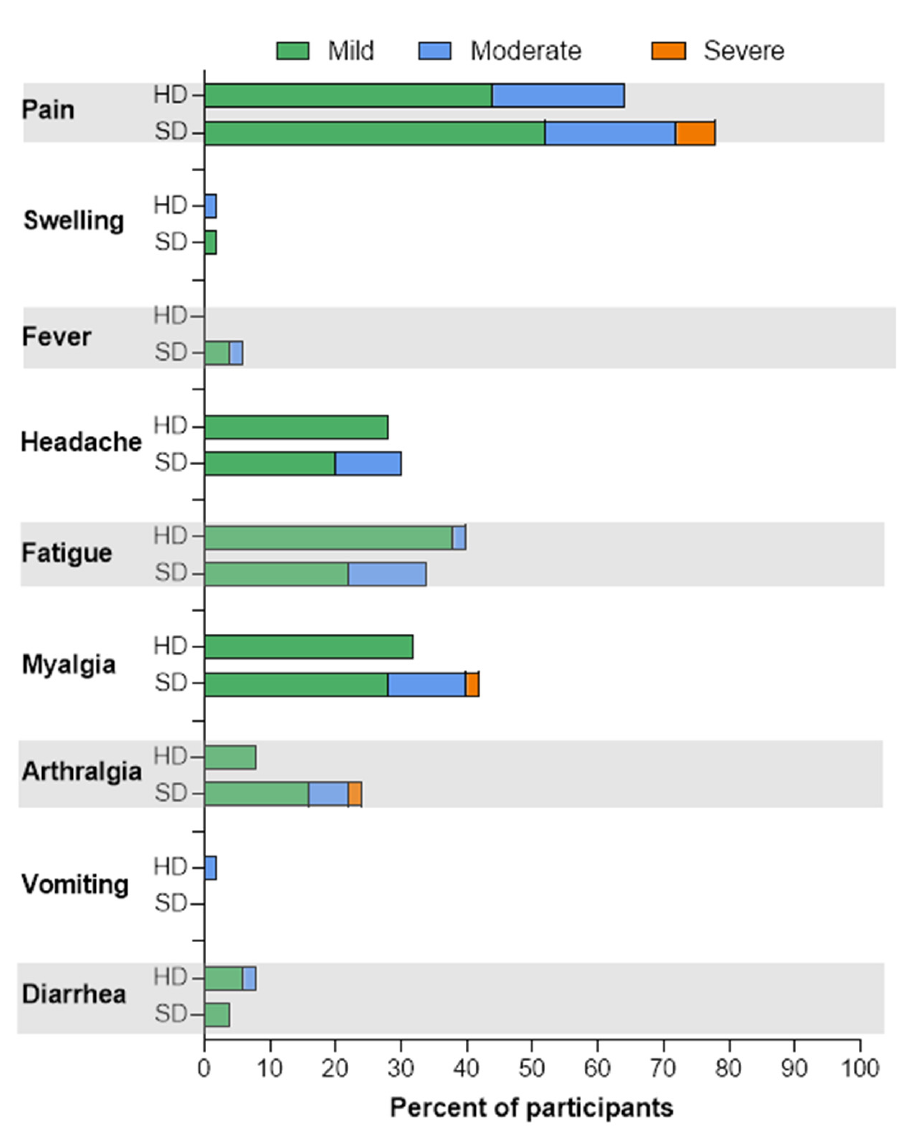
Figure 1. Local and systemic reactogenicities after the BNT162b2 booster in adults following 2 doses of AZD1222, according to half-dose and standard-dose groups. HD: Half dose; SD: Standard dose.